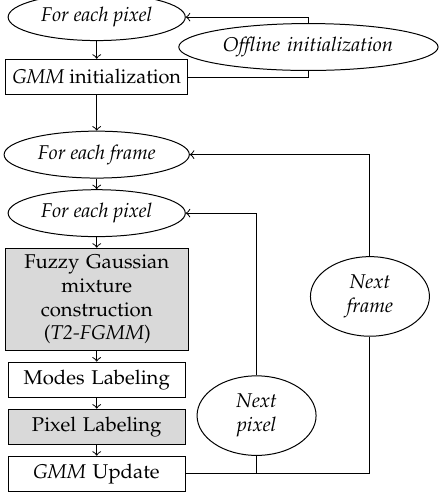
Figure 5. T2-FGMM algorithm.